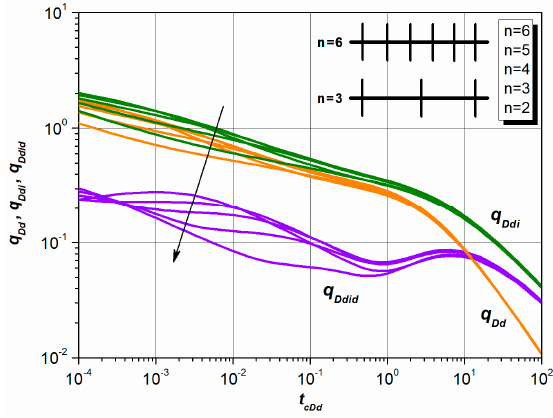
Figure 7. The effect of number of fractures on combined type curves of an MFHW.